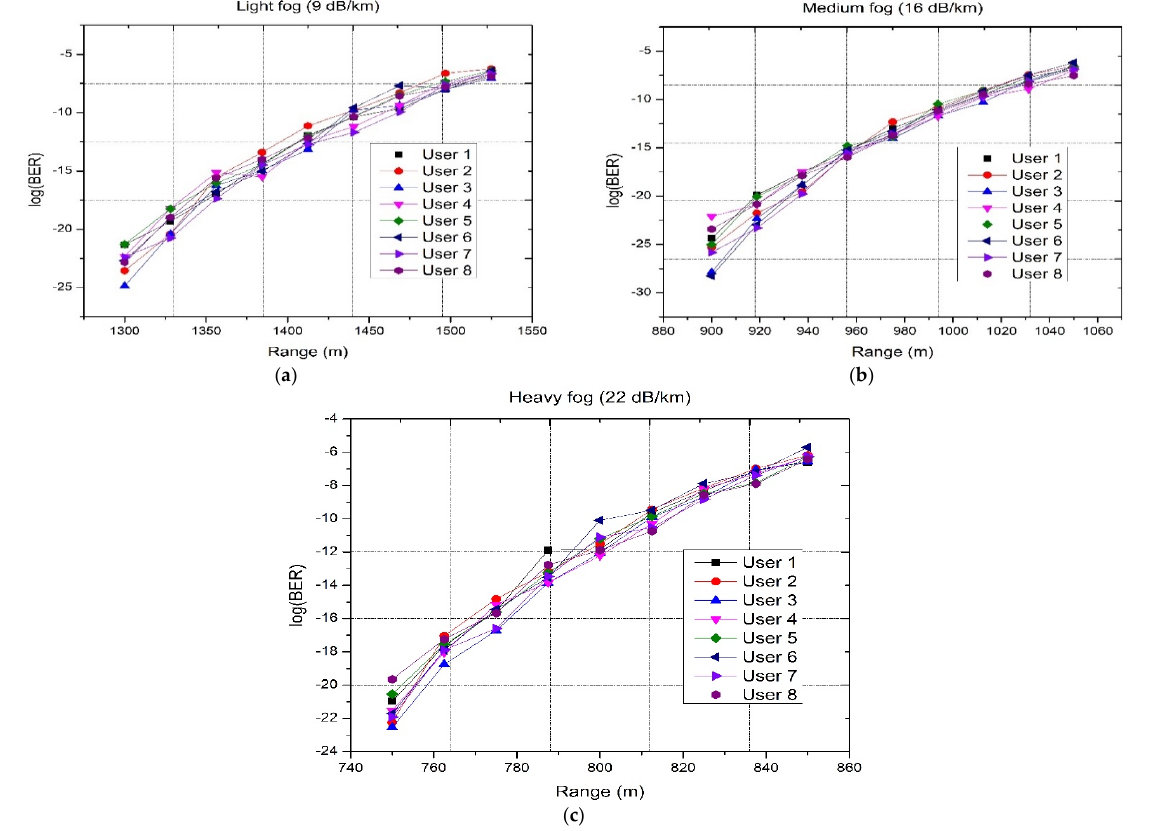
Figure 6. Log (BER) of FSO-PDM/PV-OCDMA system versus FSO link under ( a ) LF, ( b ) MF, and ( c ) HF.